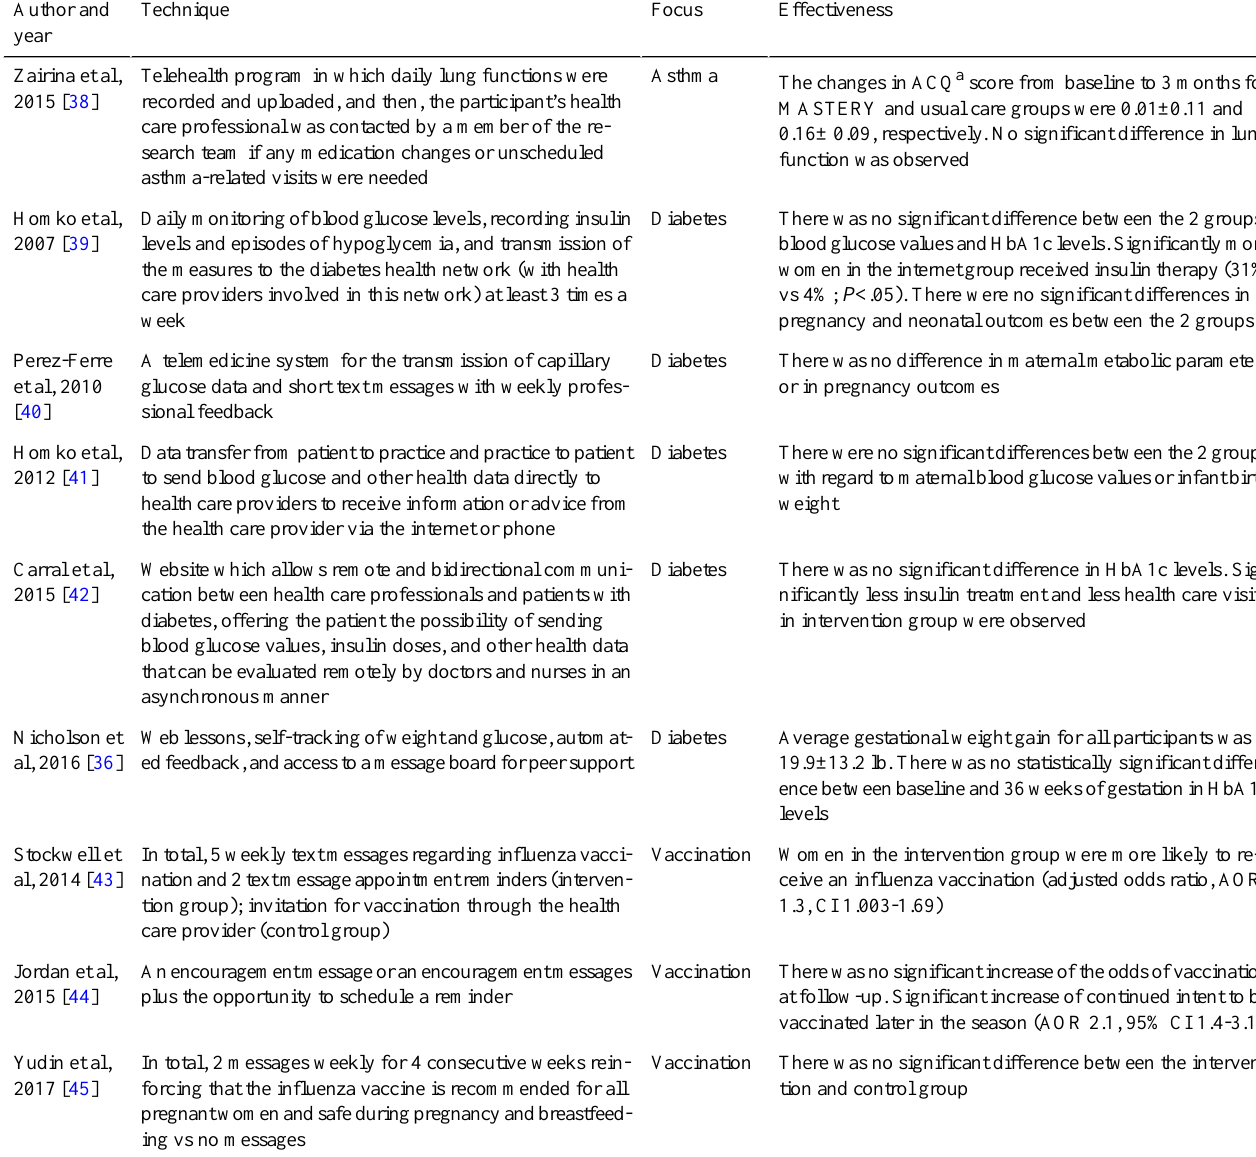
Table 3. Overview of studies reporting on medical (interventions) apps related to pregnancy: effectiveness. EffectivenessFocusTechniqueAuthor